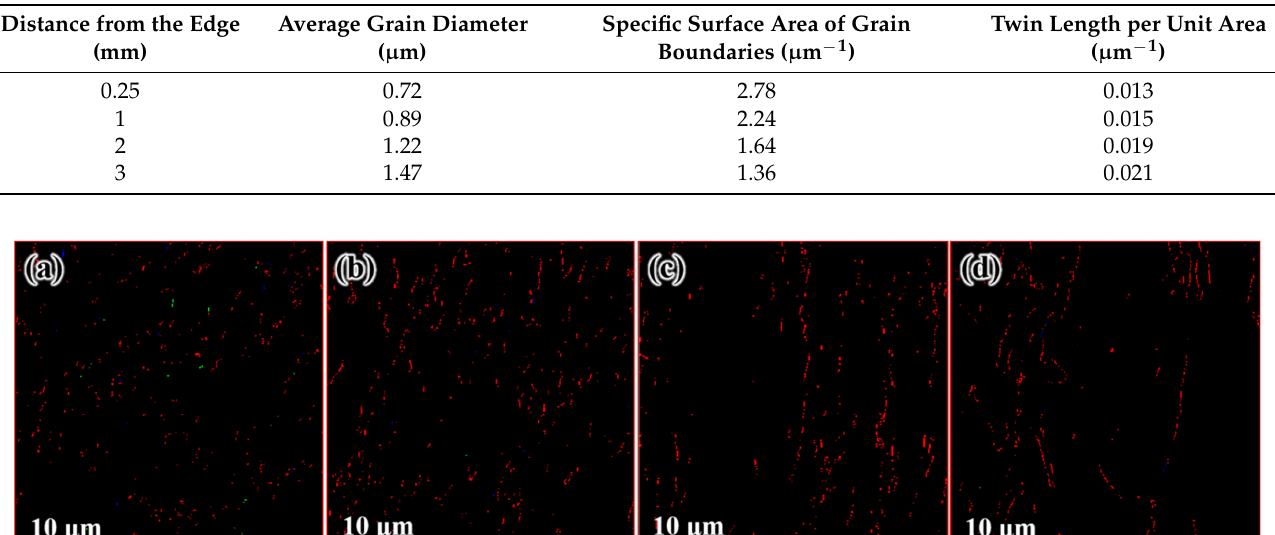
Table 4. The average grain diameter, specific surface area of grain boundaries, and twin length per unit area after FCE at room temperature.